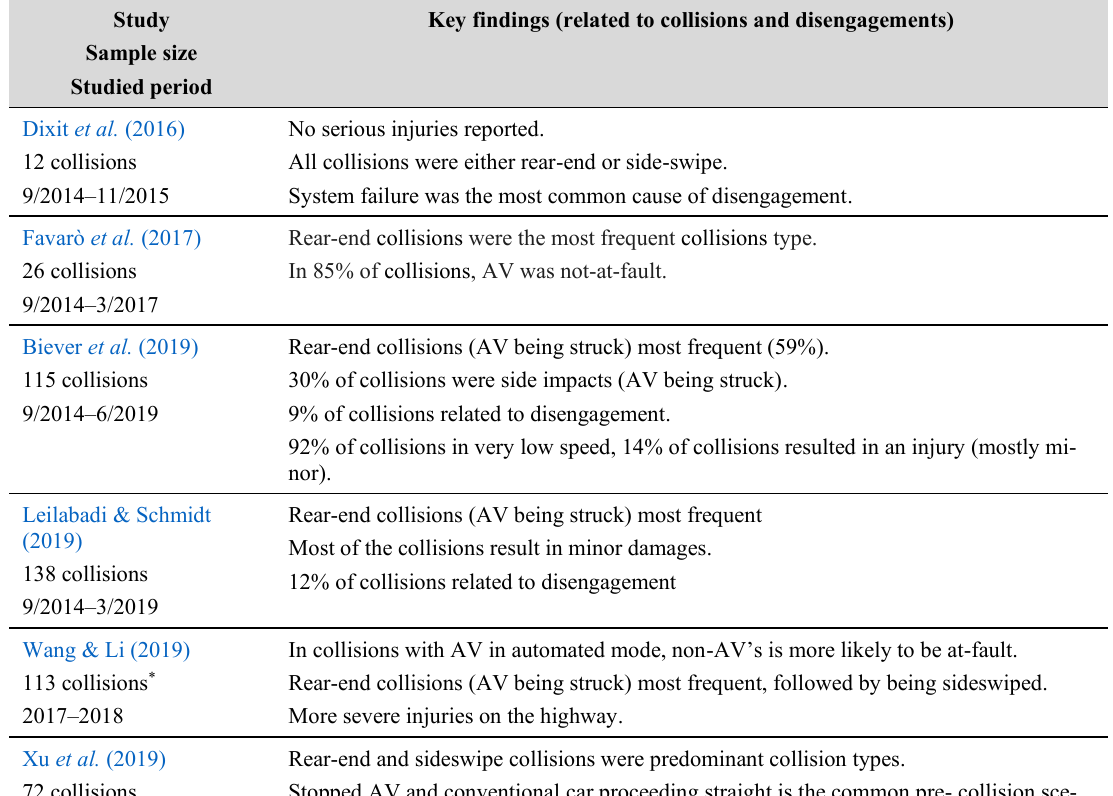
Table 1 Overview of DMV